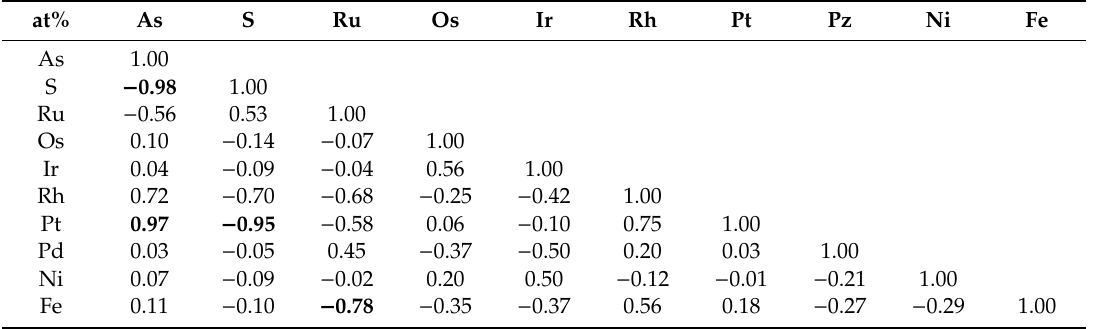
Table 3. Element correlation in the zoned laurite for the Merensky